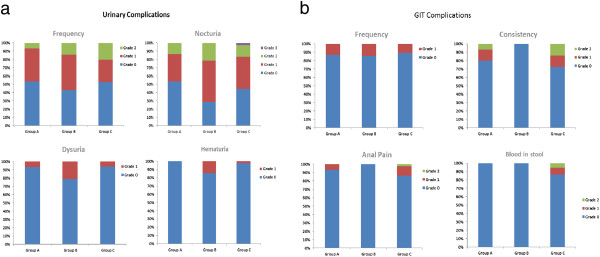
The incidence of reported late urinary (4a) and gastrointestinal (4b) complications based on LENT SOMA toxicity scale in relation to the dose group (A: 66 Gy, B: >66 <70 Gy, C: ≥ 70 Gy).≥ 70 Gy).